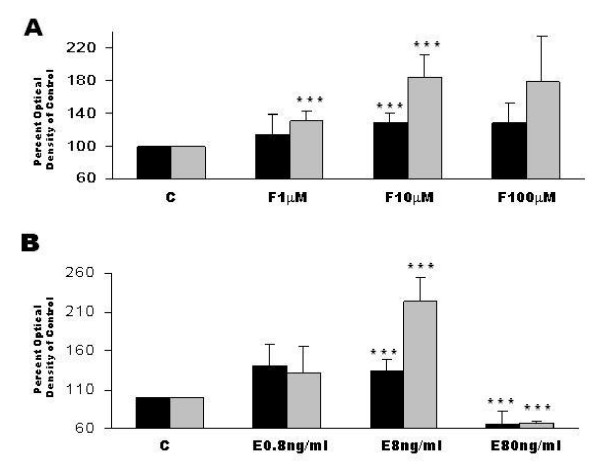
Dose-dependent effect of Forskolin and EGF on gelatinase secretion in JAR cells. JAR cell (1 × 104/well) were incubated 48 hours with or without Forskolin (1 μM, 10 μM or 100 μM) or EGF (0.8 ng/ml, 8 ng/ml or 80 ng/ml) and media collected for measurement of Gelatinase secretion. (A) Bar graph, representing mean ± SEM of 10 independent experiments, of cells treated with forskolin. (B) Bar graph, representing mean ± SEM of 10 independent experiments, of cells treated with EGF. Black bars represent proMMP-2 and gray bars represent proMMP-9. *P < 0.05 vs. control.